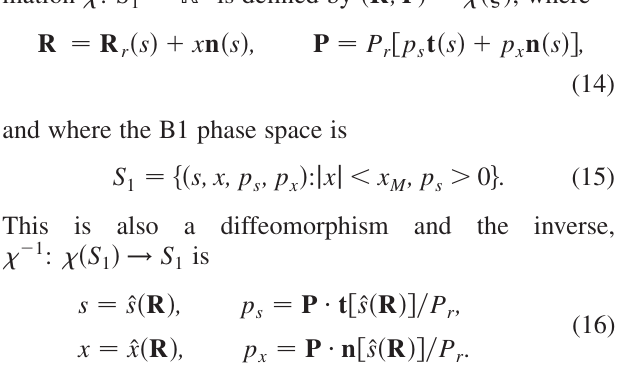
FIG. 2. Beam frame